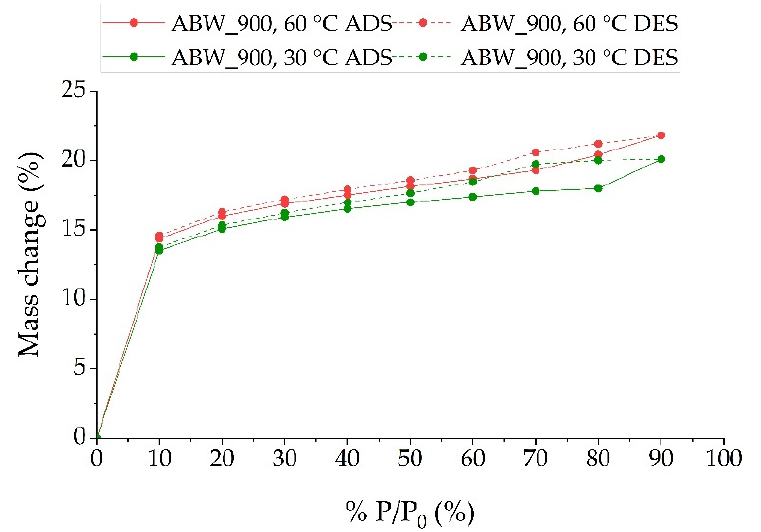
Figure 7. Adsorption and desorption isotherms for the samples ABW_900 at 30 and 60 °C.